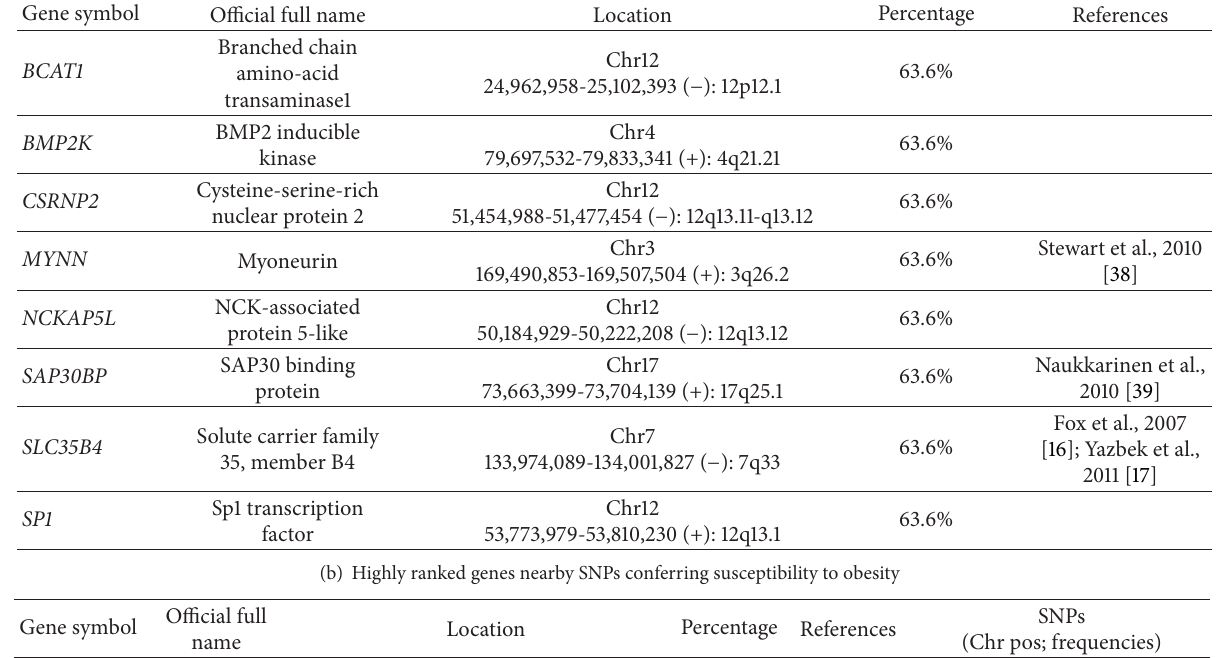
Table 2: Highly ranked genes in the obesity-control study. (a) Highly ranked genes with high percentages in obesity-control